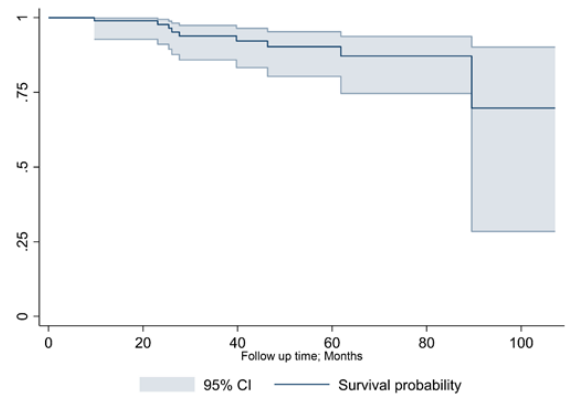
Figure 1. Kaplan-Meier Survival Plot for Death as the Survival